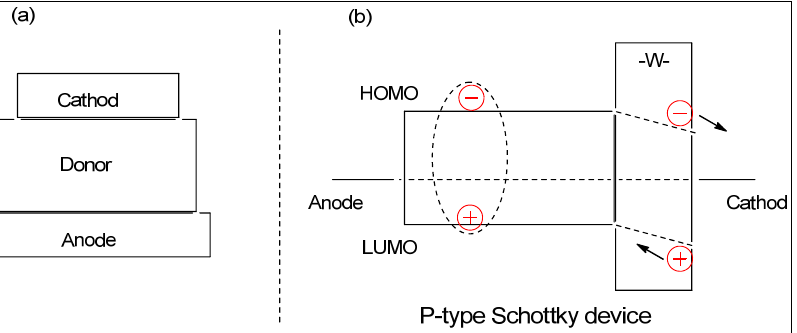
Figure 7. ( a ) Schematic of a single organic device. ( b ) In a p-type Schottky contact at the metal cathode, photogenerated excitons are dissociated in a thin depletion region W.